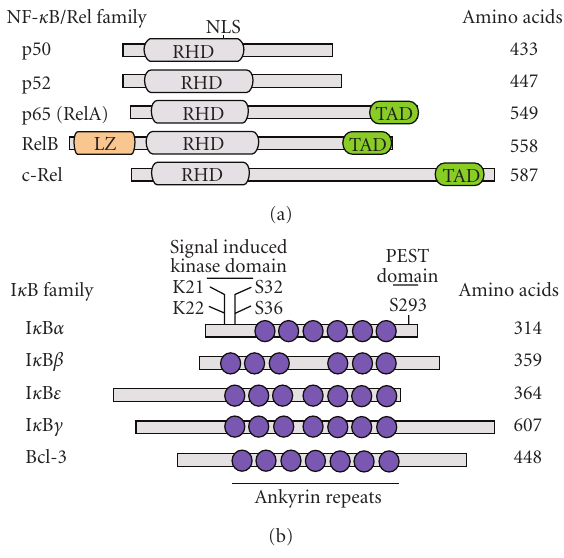
Figure 1: Structural Organization of NF- κ B / Rel and I κ B Proteins . (a) A schematic representation of some members of the Rel family of proteins. Members of this family contain a unique, highly conserved Rel homology domain (RHD) towards the N- terminus, and this domain carries a nuclear localization signal (NLS). Most members of the Rel family contain a C-terminally located transactivation domain (TAD) that is important for optimal transcriptional activity. RelB is a structurally unique member of the NF- κ B protein family in that it contains a leucine zipper-like (LZ) region at its N-terminus. (b) A schematic representation of some members of the I κ B family of proteins, which are uniquely characterized by the presence of 30-33-amino acid ankyrin (ANK) repeats. At least for I κ B α and I κ B β the most well-characterized members of the I κ B family, there are two conserved serine residues at the N-terminus preceding the first ANK repeat. Phosphorylation of these two serine residues is known to be crucial for signaling I κ B proteins for ubiquitination and proteolytic degradation. At the C-terminus of I κ B proteins, there is a region rich with proline, glutamate, serine, and threonine residues, and hence, it is named the PEST domain. The number of amino acid residues within the indicated proteins in mouse is